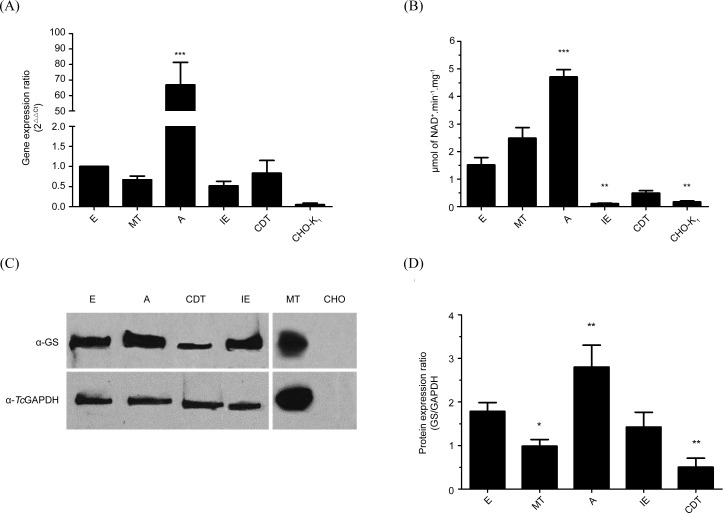
Expression profile of GS in T. cruzi.(A) Quantification of transcripts for the TcGS gene in the different stages of T. cruzi. The mRNA was quantified by qRT-PCR using primers for a fragment of the gene. The TcGAPDH gene was used as a normalizer (kept in-house). The expression ratio was calculated by the 2-ΔΔCt method, in which E stage expression was defined as 1. The cDNA of CHO-K1 cells was used as a negative control since this strain is used to obtain the intracellular forms of T. cruzi. The differences between the expression profiles were evaluated by a one-way ANOVA test (p <0.05). In (B), the specific activity of GS was evaluated in the different stages of T. cruzi. The measurement of enzymatic activity was performed as described previously for the parasite extracts. (C) shows a representative Western blot performed with protein extracts of the T. cruzi stages. The extracts were resolved on denaturing polyacrylamide gel (10% acrylamide), transferred to a nitrocellulose membrane and incubated with anti-GS antibody (Sigma- Aldrich, St. Louis, Missouri, USA). The membranes were incubated with a secondary anti-rabbit IgG (Sigma- Aldrich, St. Louis, Missouri, USA) antibody for chemiluminescent detection. In this case, the stripping process was performed by adding 0.2 M NaOH. After two washes with PBS, incubation was performed using the same process described above, but the primary antibody was changed to anti-GAPDH (Sigma- Aldrich, St. Louis, Missouri, USA). Lanes: E: Epimastigote; A: Amastigote; CDT: Trypomastigotes; IE: Intracellular epimastigotes; MT: Metacyclic trypomastigotes; CHO: non-infected CHO-K1 cells. (D) Densitometry analysis of Western blot bands (three independent experiments including that of panel C). Asterisks indicate statistical analysis by 1way ANOVA / Tukey’s Multiple Comparision Test for (A) and Dunnet’s Multiple Comparision Test for (B) and (D); *p<0.05, **p<0.01, ***p<0.001, error bars represent standard deviation (n = 3).